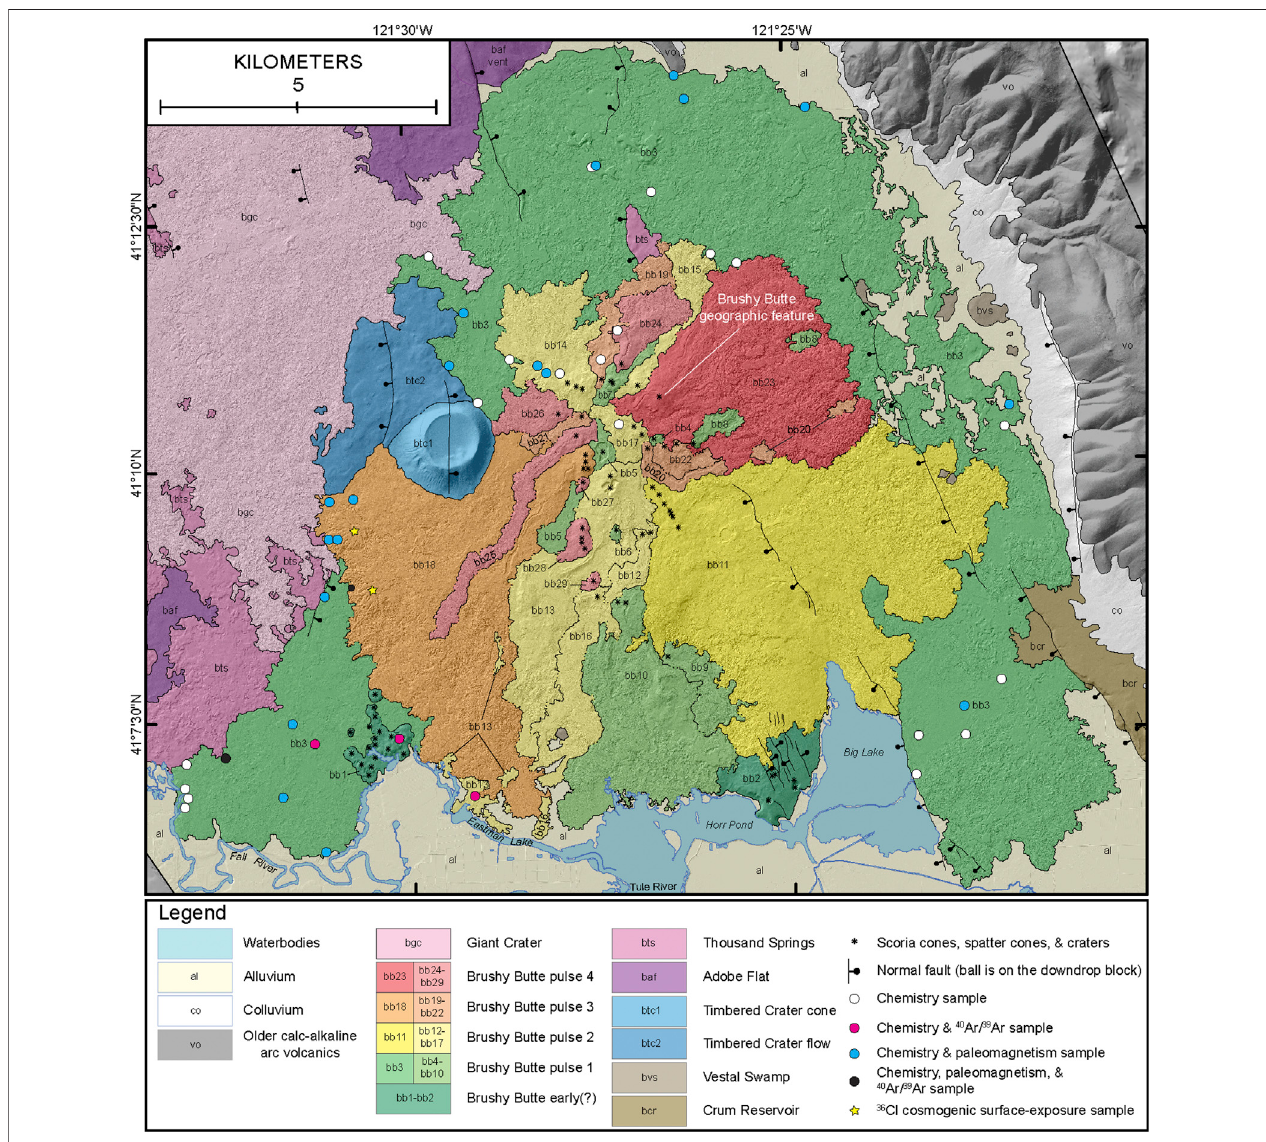
FIGURE 3 | Geologic map of the Brushy Butte fl ow fi eld (with the Brushy Butte geographic feature noted), surrounding tholeiitic basalts, alluvium, colluvium, and older calc-alkaline volcanic rocks. Monogenetic tholeiitic basalt fl ows erupted during the Pleistocene are arranged in stratigraphic order from youngest (Giant Crater) to oldest(CrumReservoir).TheBrushyButte fl ow fi eldisdividedintounitsbb1 – bb29,whichareplacedwithintheearly(?)BrushyButte(bb1 – bb2),withtheremainingunits making up pulses 1 – 4. Pulses 1 – 4 are divided into their initially erupted fl ows (darker color in the legend) followed by the rest of the eruptions of that pulse (lighter color of the same pulse in the legend).